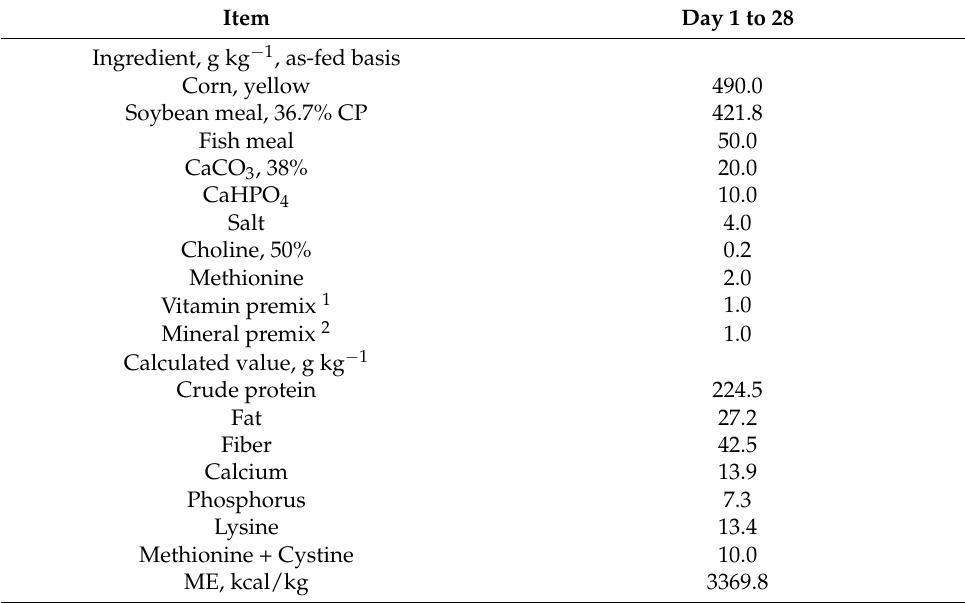
Table 1. Nutrient composition of basal